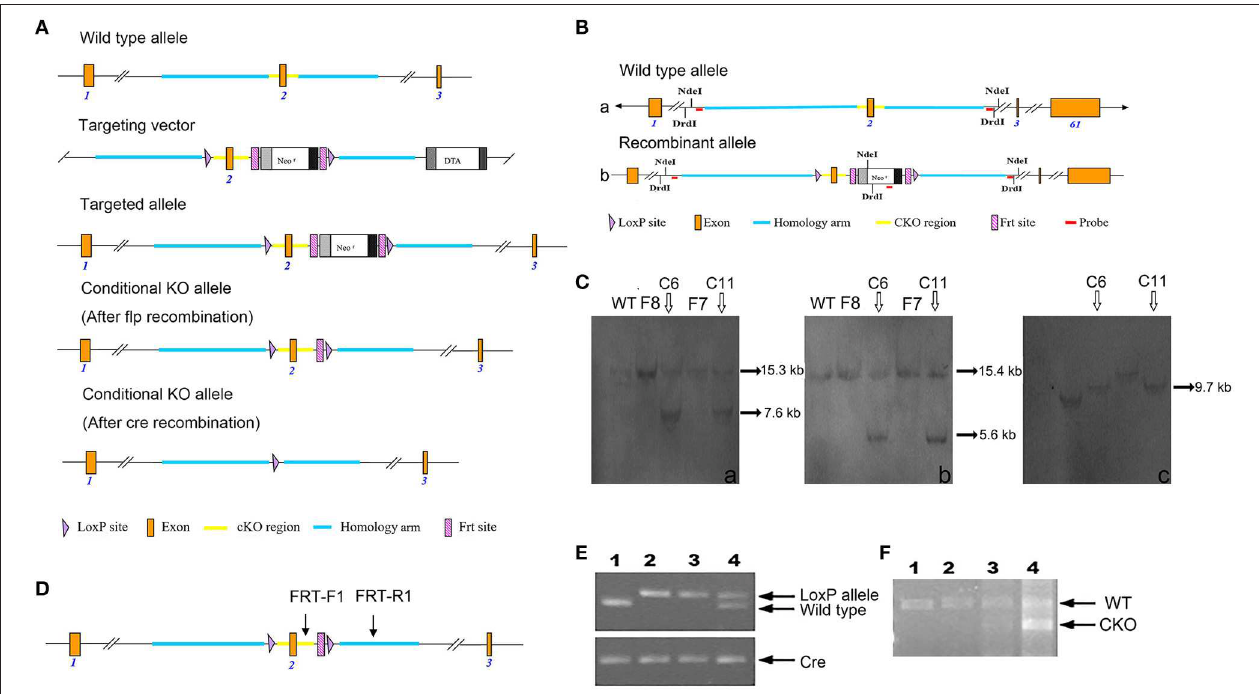
FIGURE 1 | Generation of Fry CKO mice and genotyping. (A) Schematic explanation of the gene targeting strategy. (B) Southern blot strategy. Structure and restriction map of the wild-type Fry allele (a). Structure and restriction map of the recombinant Fry allele with insertions of two loxP sites in intron 1 and intron 2 and a neo gene flanked by Frt sits in intron 2 (b). (C) Southern blot analysis of the targeted clones. Six potential targeted clones were identified, four of them (F8, C6, F7, C11) were expanded and frozen, the Southern blot analysis was conducted by 5 ′ -probe, 3 ′ -probe, and Neo-probe. 5 ′ probe. The genomic DNA of the potential clones F8, C6, F7, C11 was digested by NdeI and analyzed by Southern blot for a 15.3kb band from wildtype allele and a 7.6kb band from recombinant allele, C6 and C11 were positive (a). 3 ′ probe. The genomic DNA of the potential clones F8, C6, F7, C11 was digested by DrdI and analyzed by Southern blot for a 15.4kb band from wildtype allele and a 5.6kb band from recombinant allele, C6 and C11 were positive (b). Neo probe. The genomic DNA of the potential clones F8, C6, F7, C11 were digested by NdeI and analyzed by Southern blot for a 9.7kb band from recombinant allele, C6 and C11 were positive (c). (D) PCR genotyping strategy. Where conditional Fry KO allele, primers FRT-F1/FRT-R1 amplified a 719 bp product. Wild-type animals without the LoxP and Frt sites amplify a 583-bp PCR product using primers FRT-F1/FRT-R1. Arrows show positions of PCR primers used for detecting products of recombination. (E) PCR analysis of MMTV-cre-mediated recombination in Mfry and WT mice. Offspring with the desired genotypes were identified by PCR analysis of tail DNA. MMTV-cre mice were identified by Cre primers. The wild-type PCR product is 583 bp and the recombined is 719 bp. (1) Wild-type ( Fry + / + , cre) mouse; (2, 3) Mfry ( Fry LoxP / LoxP , cre) mouse; (4) Heterozygous ( Fry LoxP / + , cre) mouse. (F) QPCR analysis the expression of FRY in the mammary gland of Mfry and WT mice. The wild-type PCR product is 782 bp and the recombined (exon 2 knockout) is 582 bp. (1, 2) Wild-type ( Fry + / + , cre) mouse; (3, 4) Mfry ( Fry LoxP / LoxP , cre)